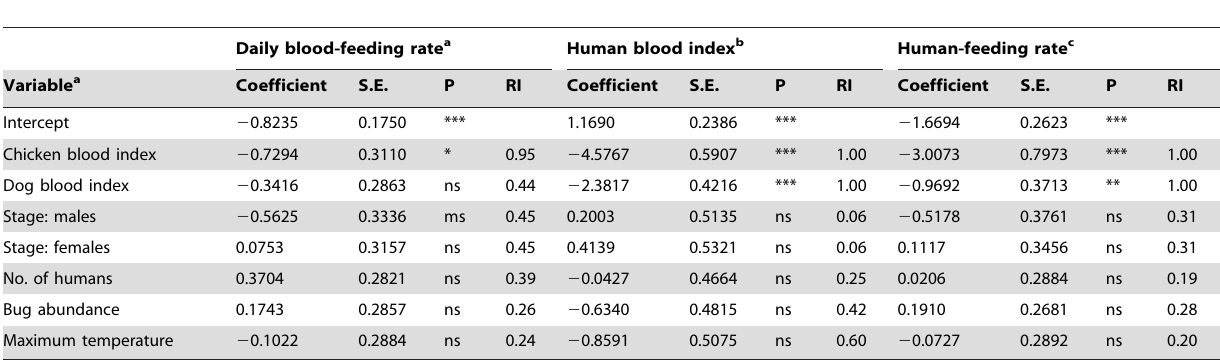
Table 1. Model-averaged coefficients of factors associated with the daily blood-feeding rate, human blood index, and daily human-feeding rate of domestic T. infestans in Figueroa, spring 2003.